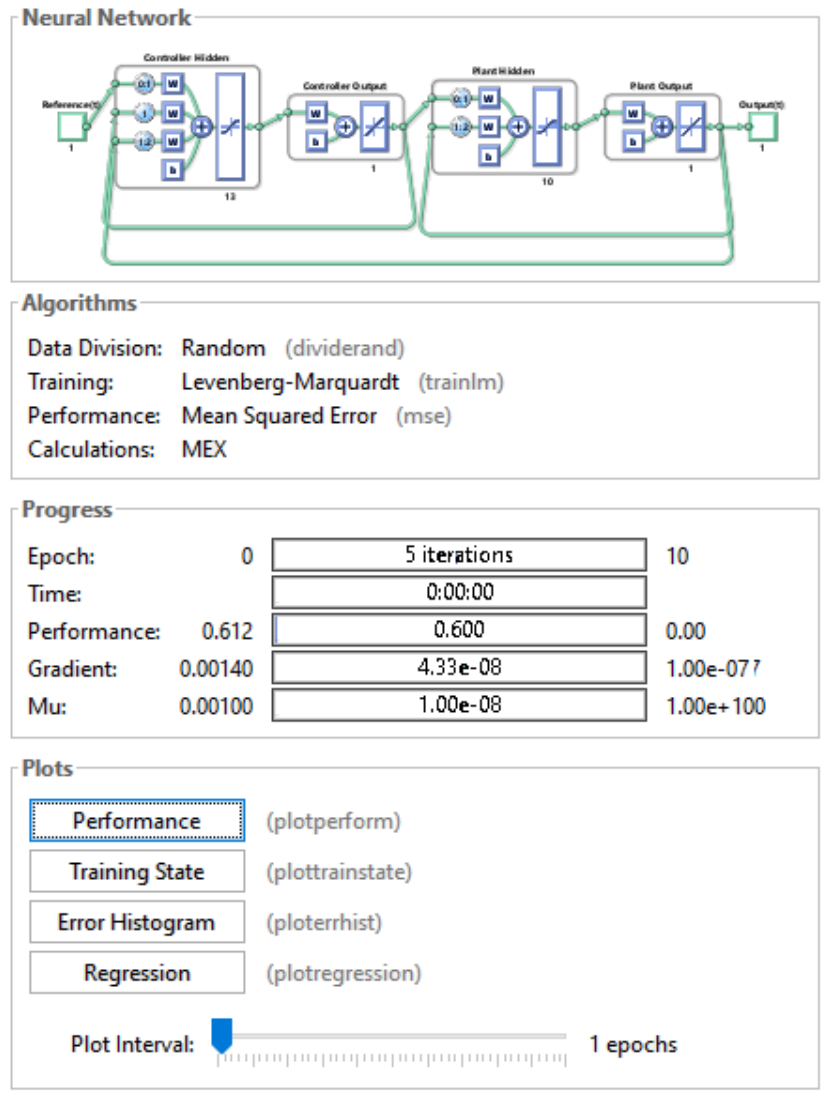
Figure 40. Neural network controller training parameters.